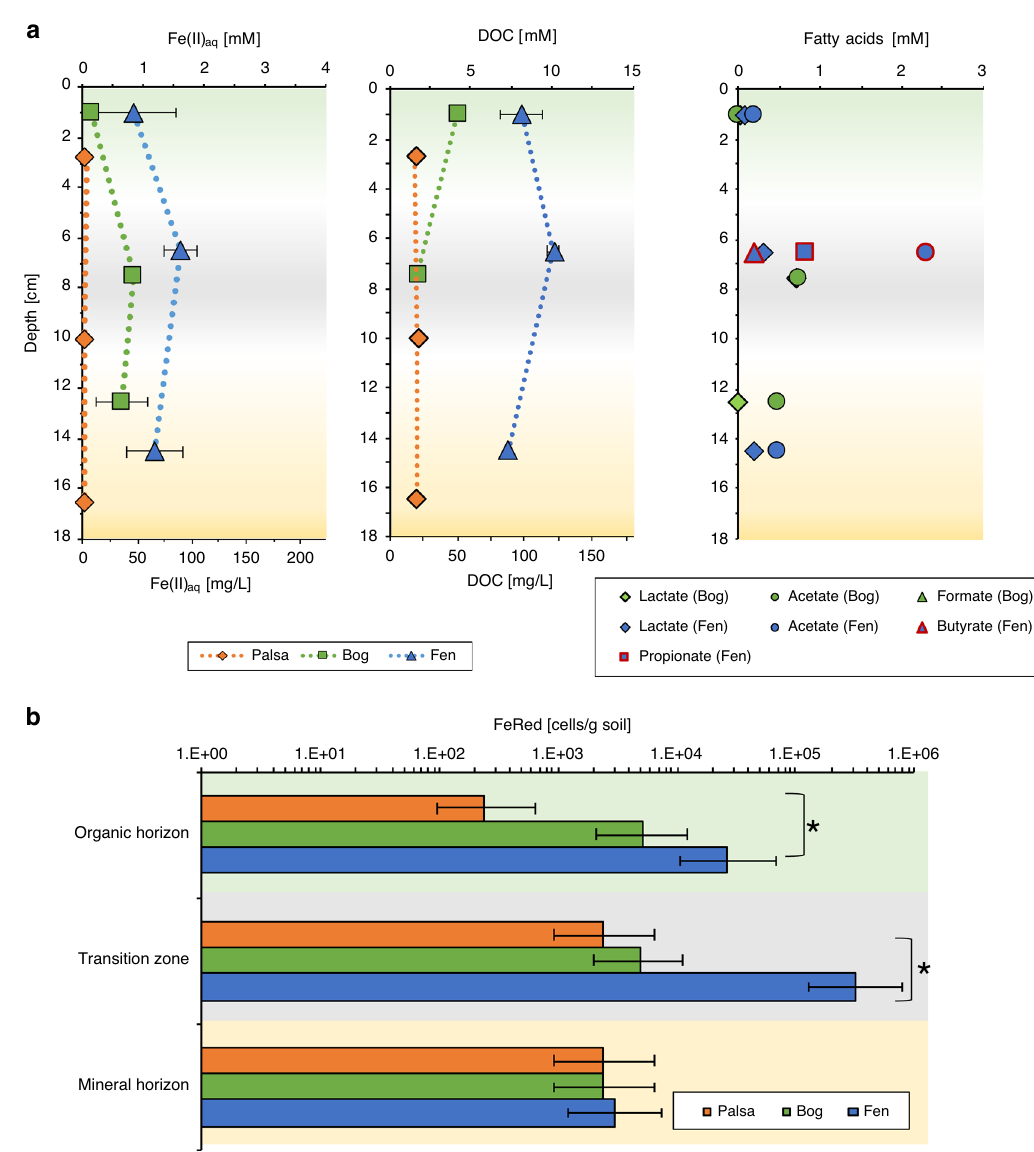
Fig. 2 Increasing iron and dissolved organic carbon concentrations accompanied by an increase in abundance of Fe(III)-reducing bacteria along the permafrost thaw gardient. a Porewater geochemical analysis of the cores Palsa A, Bog C, and Fen E and b most probable number quanti fi cations of Fe(III)- reducing bacteria (FeRed) in the solid phase of the cores Palsa A, Bog C, and Fen E along the thaw gradient. Red marks the high acetate concentrations in the fen, in comparison to the bog, and the additional fatty acids butyrate and propionate, only detected in the fen. The error bars of the porewater data represent triplicate measurements. The error bars of the most probable number estimations of Fe(III)-reducers represent seven replicate analyses and indicate lower and upper limits of the 95% con fi dence intervals; * marks signi fi cant difference between FeRed in palsa and fen, organic horizon, and transition zone (unpaired t -test, N = 7, α = 0.05, p = 0.0001). The green background marks the organic horizon, gray the transition zone, and yellow the mineral horizon. The backgrounds for the porewater geochemistry are shaded due to the fact that this represents three cores, one core per thaw stage, with different horizon